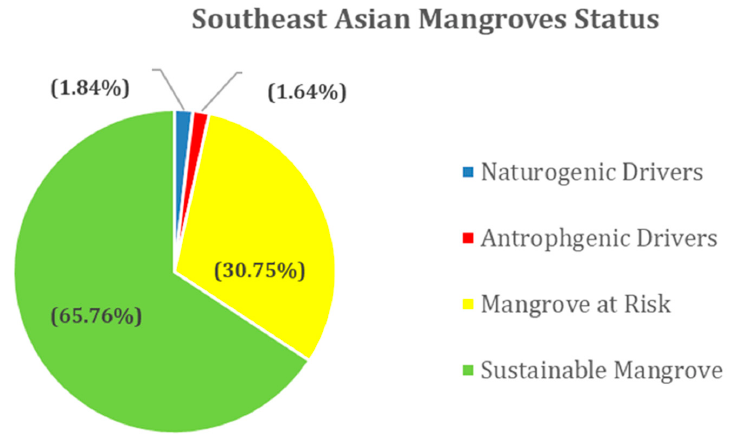
Figure 10. Relationship classifications between land use land cover and mangrove forests’ water balance with the degradation and depletion condition of them.